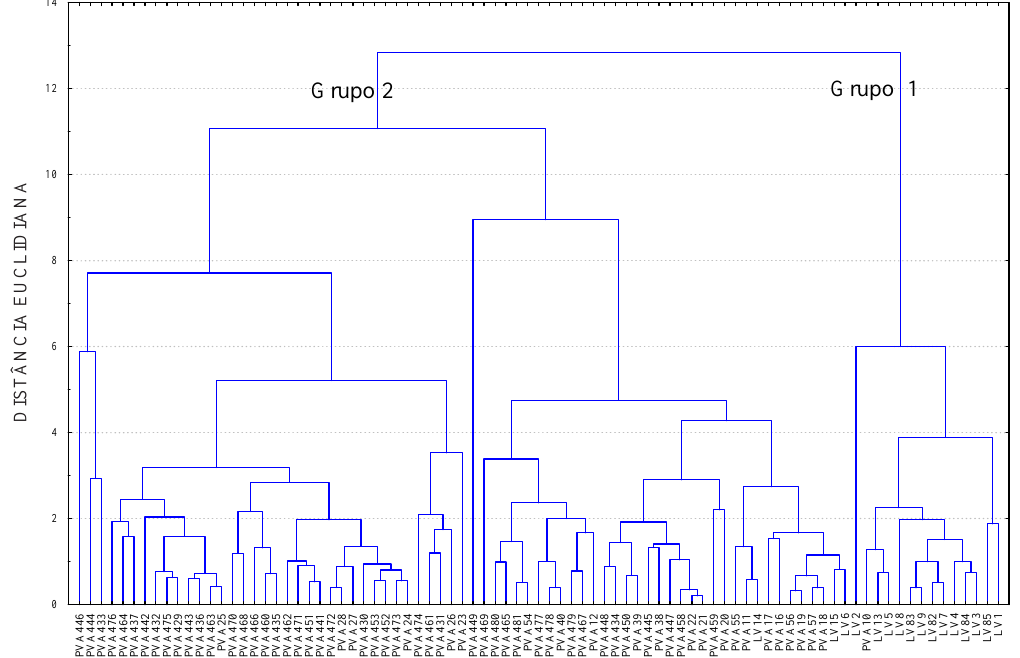
Figura 1. Fenograma da análise de cluster das características morfológicas das microbacias hidrográficas de 2 a ordem de magnitude da Bacia Hidrográfica do Córrego Rico,